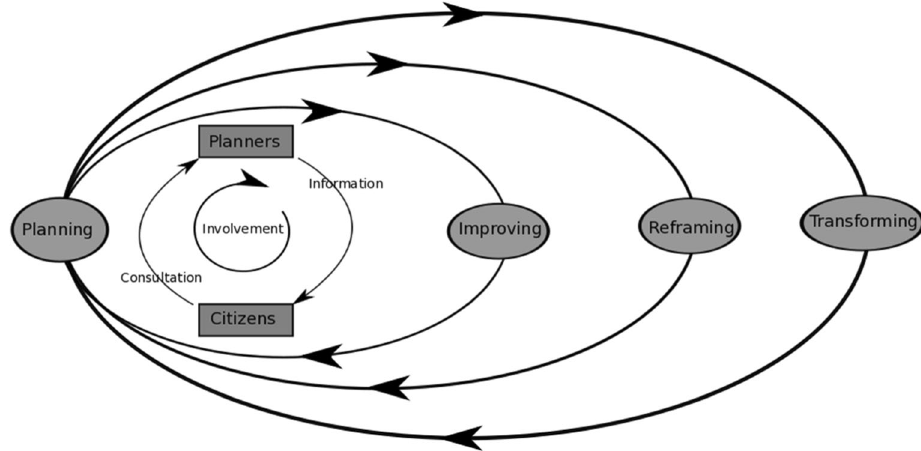
Fig. 1 Framework for social learning through participation. Participation is at the centre of each of the learning loops, emphasizing the contribution of participation to social